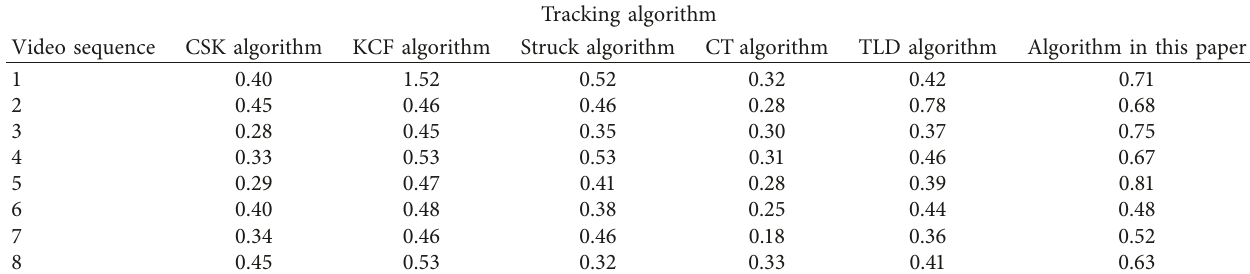
Table 2: Comparison of success rates of different algorithms.